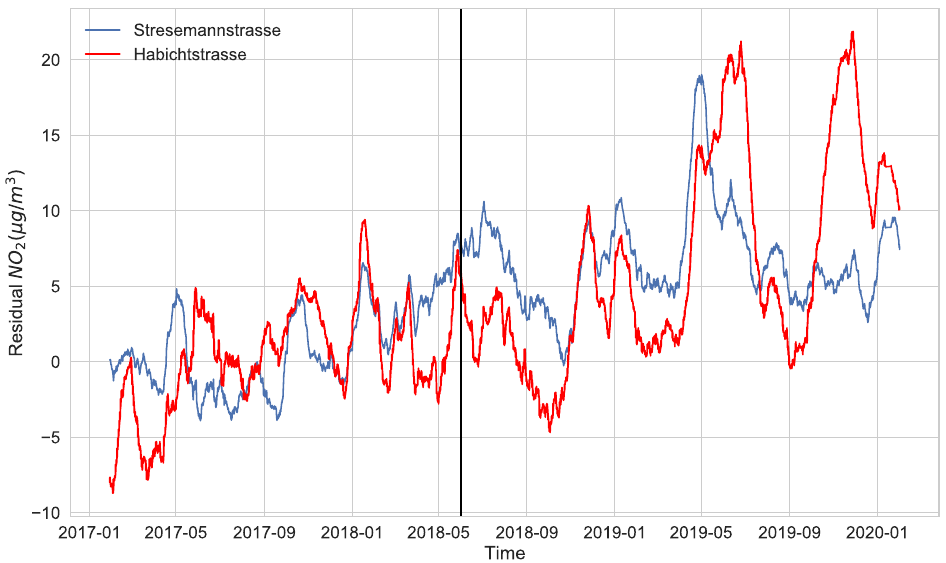
Figure 8. Moving averages (four-weekly) of difference between prediction and observation, each for the Stresemannstrasse and Habichtstrasse stations.